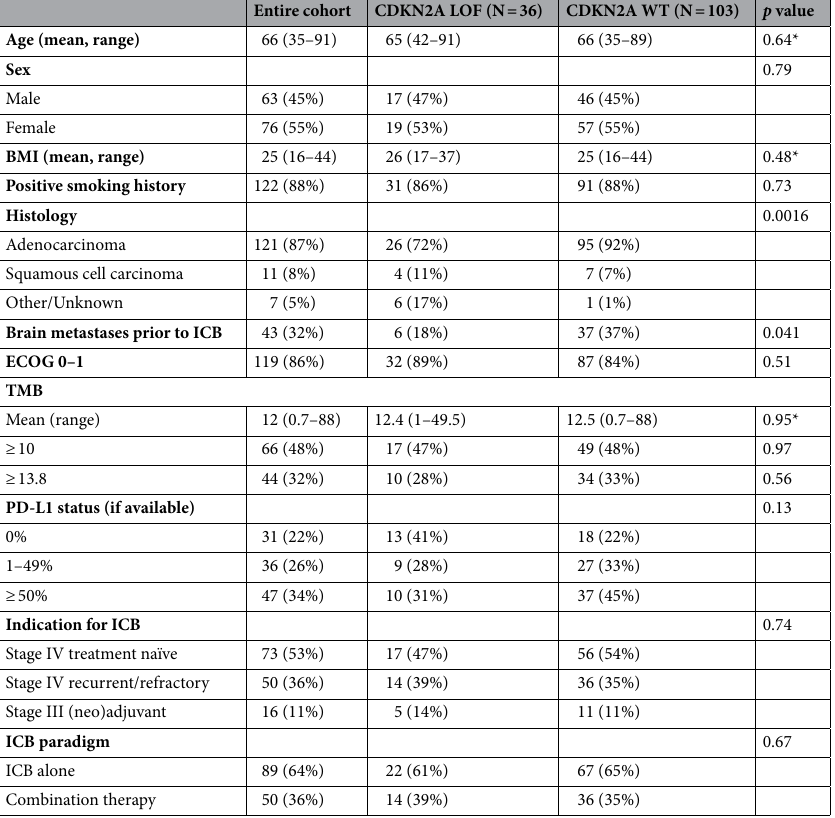
Table 1. Patient and treatment characteristics. p value determined using Chi-squared test unless otherwise noted. *Two-tailed Student’s t